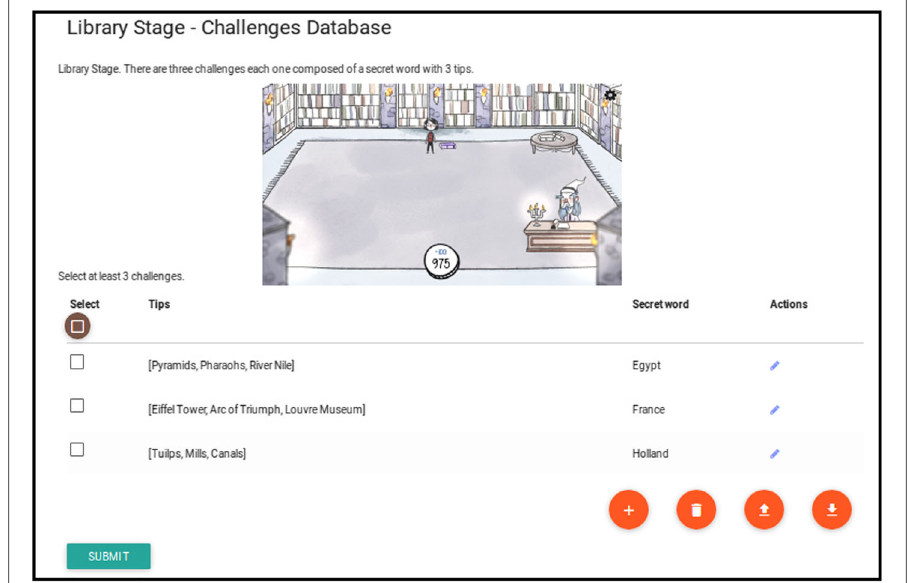
Fig. 5 Library: customisation of challenges through REMAR